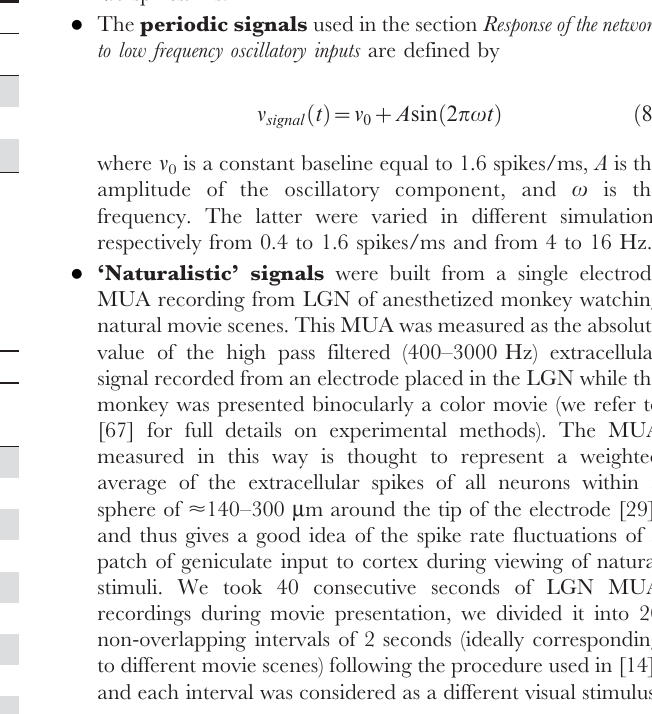
Table 3. Synaptic times